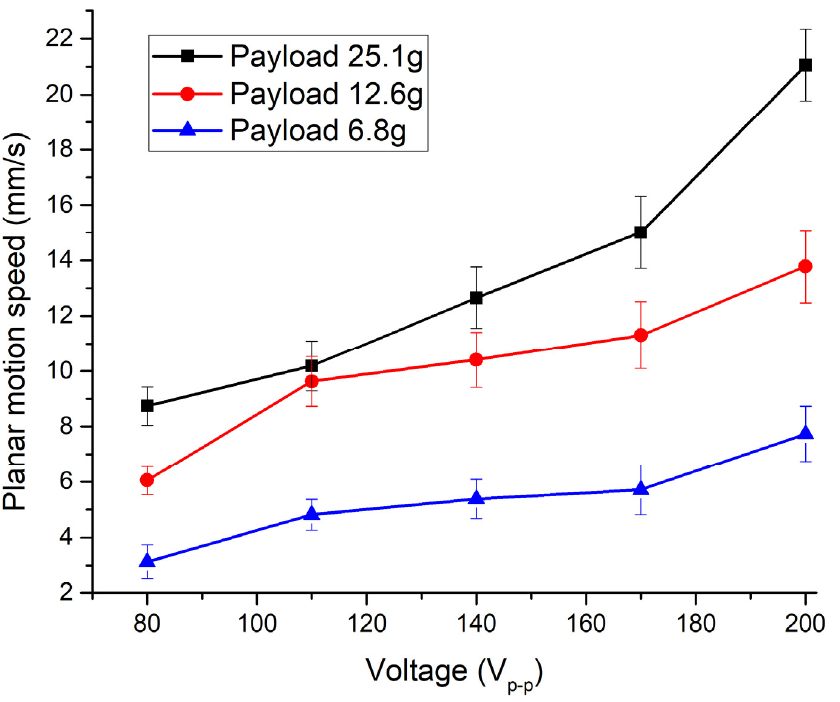
Figure 16. Measured planar motion speed of the robot at different payloads when segment L 0deg is